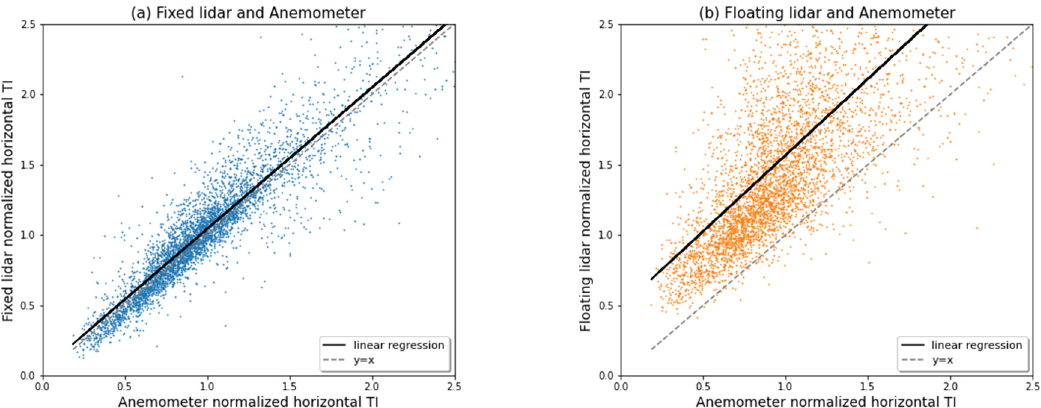
Figure 12. Linear regression of turbulence intensity measurements by the fixed ( a ) and floating ( b ) LIDARs in comparison with the cup anemometer measurements, at altitude 54.8 m. The ticks are normalized by the anemometer mean TI from all the 10-min samples.